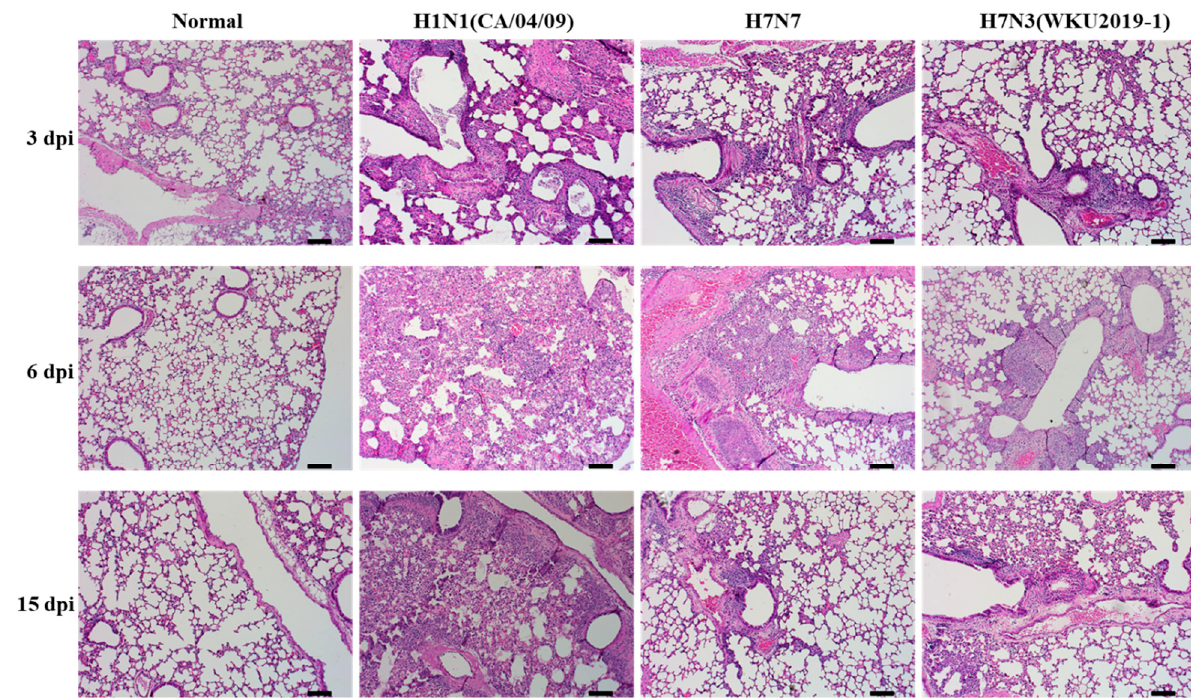
Figure 6. Histology of lung inflammation determined by hematoxylin and eosin (H&E) staining. For each isolate, BALB/c mice were intranasally infected with EID 50 concentrations of the virus at 10 5 EID 50 /mouse. The uninfected control (normal); H7N3 (WKU2019-1)-; H1N1 (CA/04/09)-; and H7N7-infected mouse lungs were collected and stained with H&E at days 3, 6, and 15 post-infection (dpi) (scale bar, 100 µm; original magnification × 100).